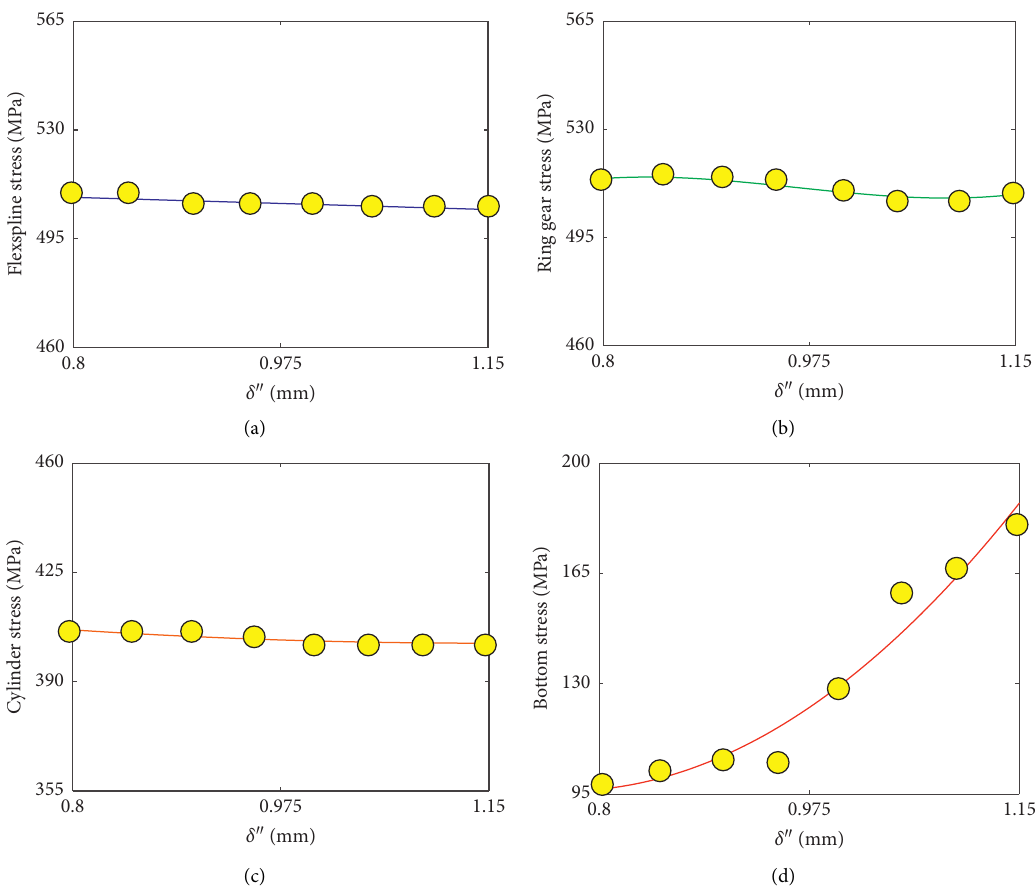
Figure 14: Stress influence curve of different wall thicknesses on the bottom of flexspline. (a) Flexspline stress. (b) Ring gear stress. (c) Cylinder stress. (d) Bottom